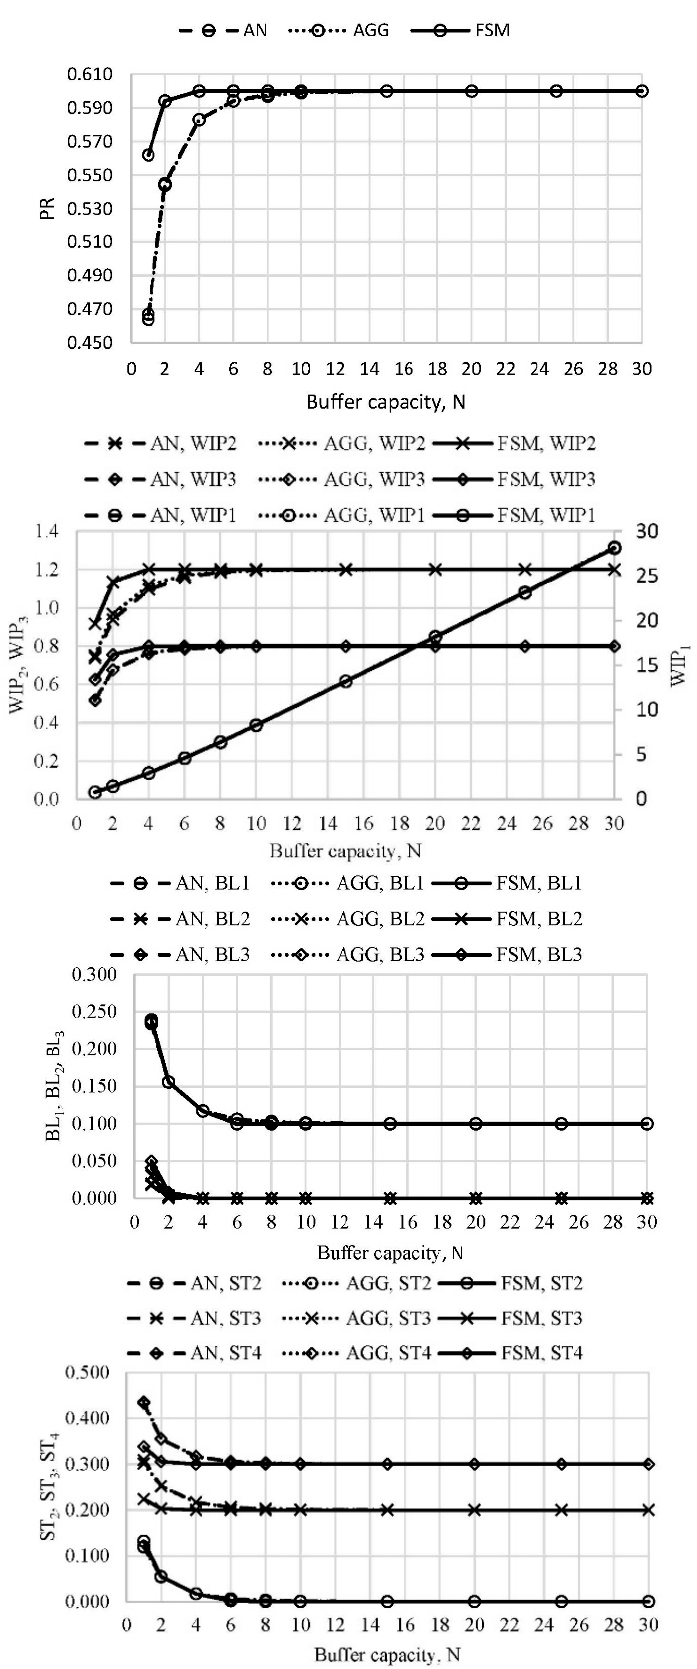
Figure 10. Performance measures of the line L 3B ( N 1 = N, N 2 = 2 N , N 3 = N ) (authors’ work).